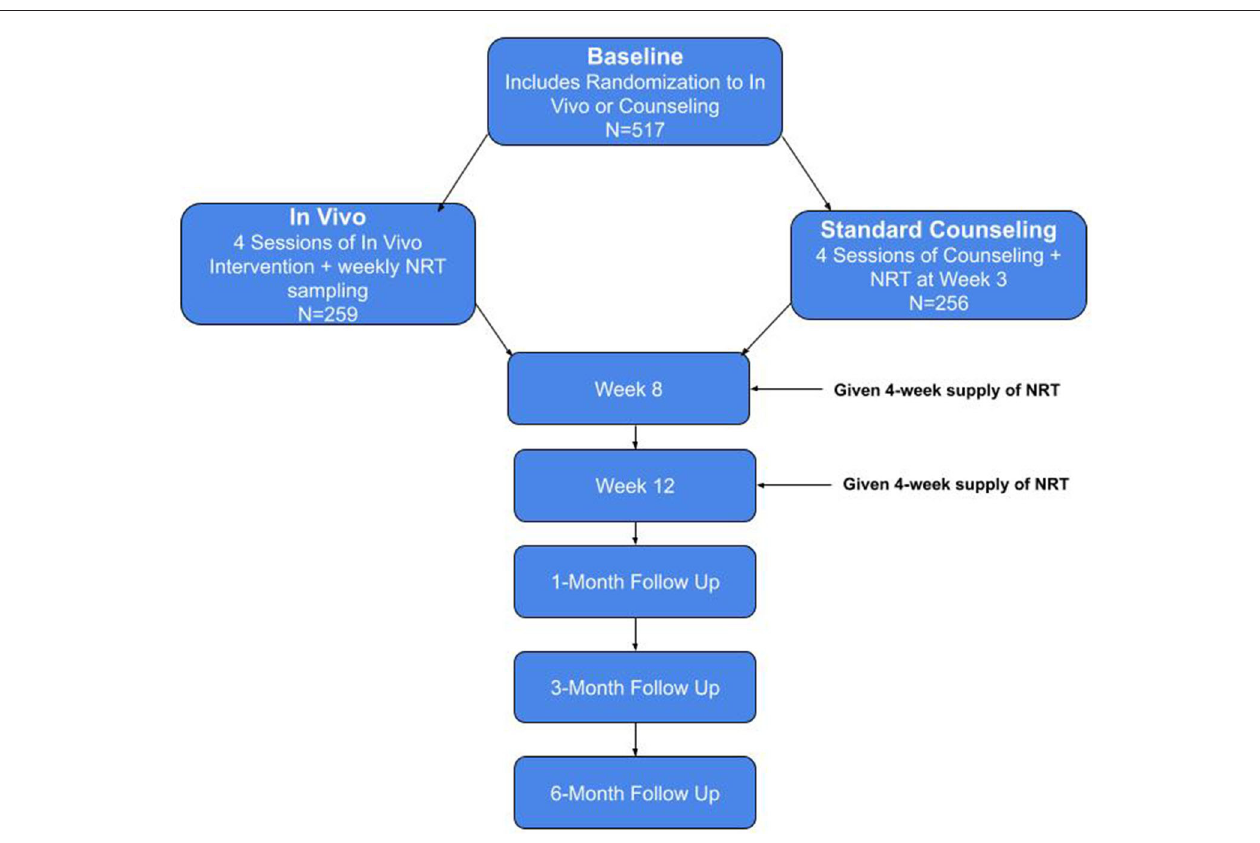
FIGURE 1 | Study flow chart.